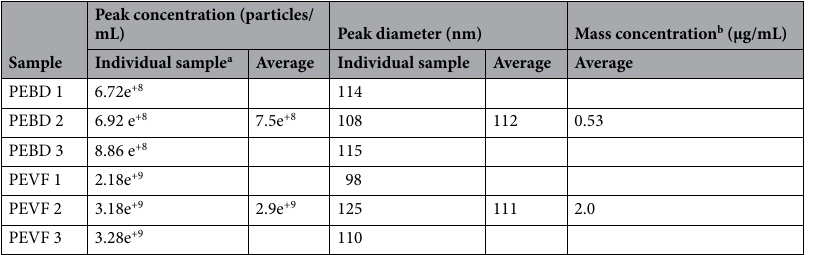
Table 1. NTA data for the different fractions. a The value is the average of five individual measurement of the specific sample. b The value is calculated using the density 0.97